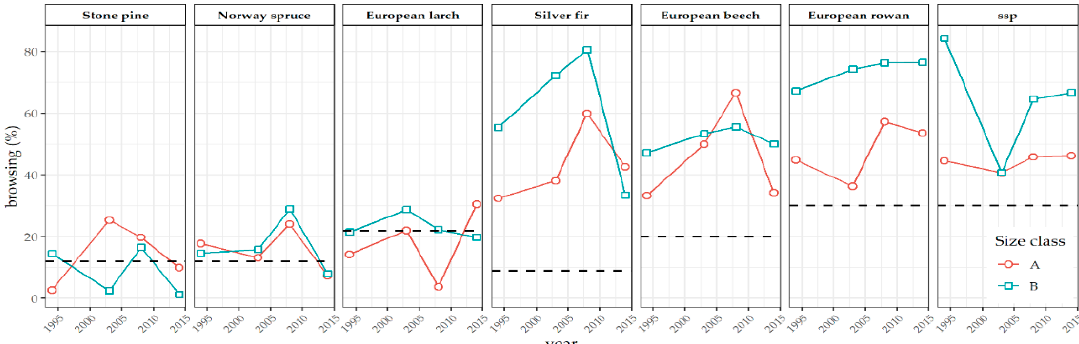
Figure 1. Mean values of percentage of browsed trees in size classes A and B (red line and blue line respectively). The dotted lines represent the browsing thresholds suggested by Eiberle and Nigg, 1987 [16].